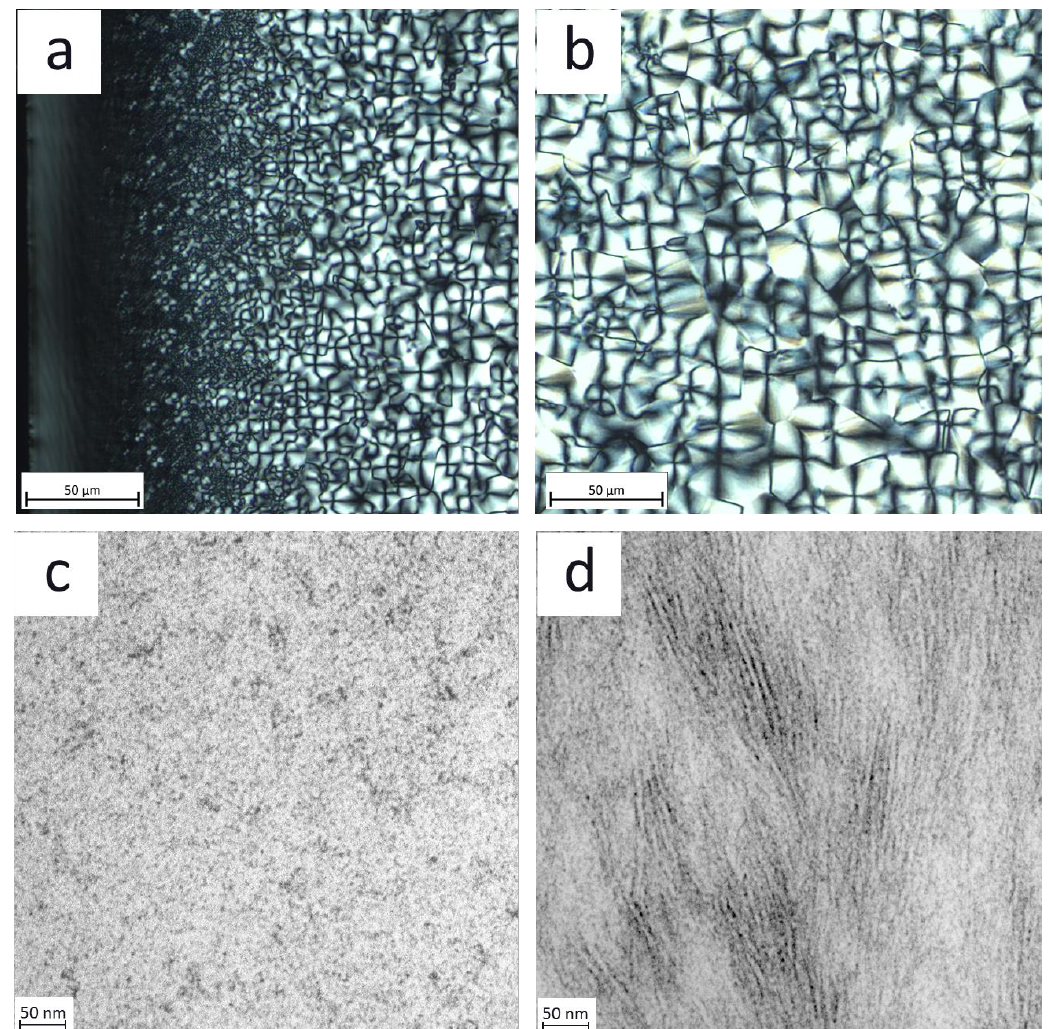
Figure 3. Optical analysis: POM micrograph of: ( a ) the skin region with increasing spherulite size and ( b ) of the core region. TEM micrograph of: ( c ) the skin region with contrast-related artefacts and ( d ) of the core region with oriented lamellae with a thickness of 5.1 nm.